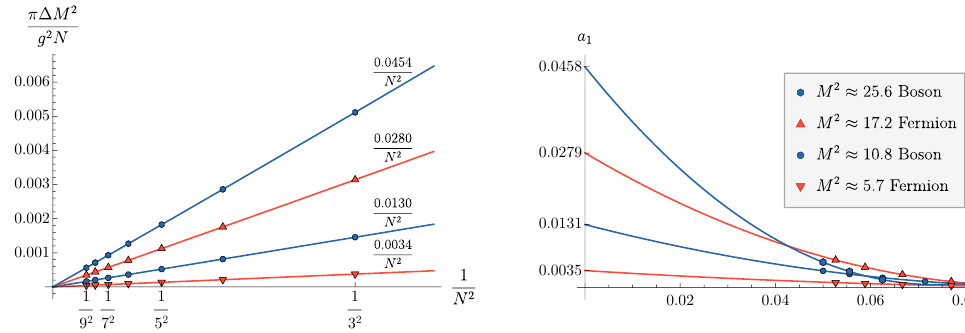
Figure 2 . For each of the lowest three bound states in the N ≥ 3 spectra, we extrapolate the difference between the finite N mass and the large N mass to the continuum, and plot this difference as a function of N − 2 . The leading order correction is seen to be of order N − 2 , with any higher-order corrections much smaller. On the right, we estimate the coefficient a 1 of the N − 2 corrections using eigenvalue perturbation theory at fixed K , and then extrapolating the results to large K . The results agree well with the fits on the